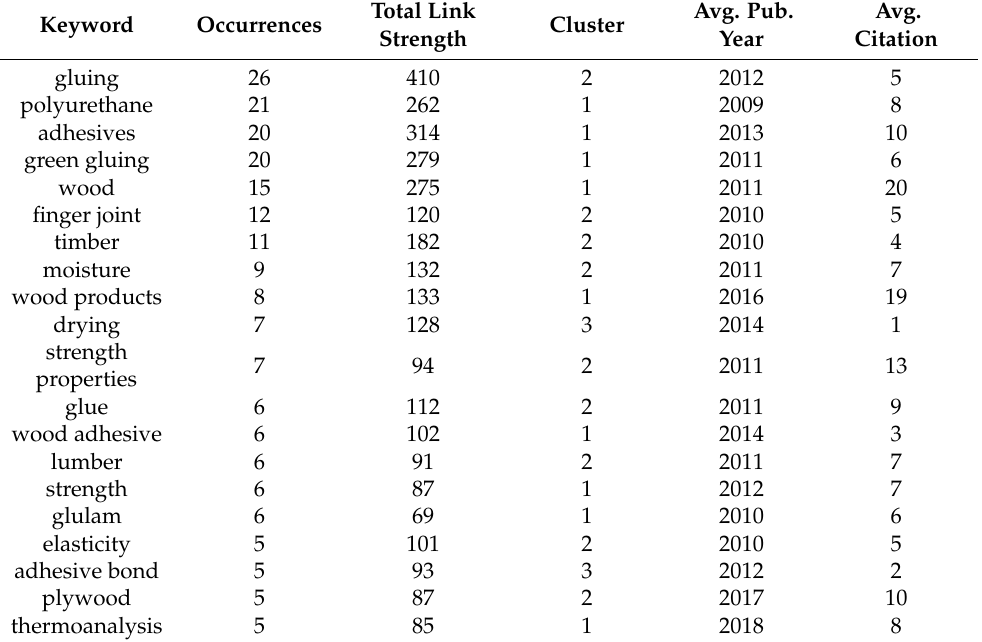
Table 5. Top Keywords with the most significant presence in the bibliometric map on “Green